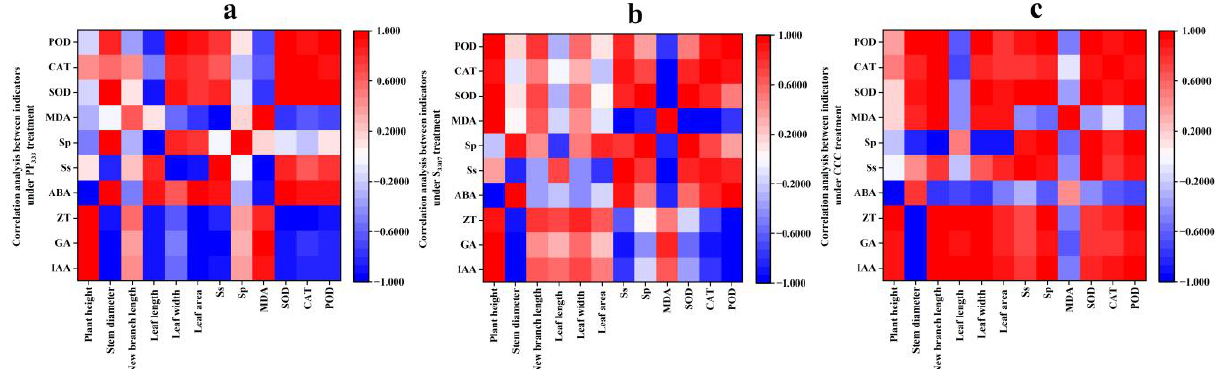
Figure 8. Correlation analysis of indexes of M. alternifolia under PGR treatments . ( a ) Correlation analysis of indexes of M. alternifolia under PP 333 treatment, ( b ) correlation analysis of indexes of M. alternifolia under S 3307 treatment, ( c) correlation analysis of indexes of M. alternifolia under CCC treatment.